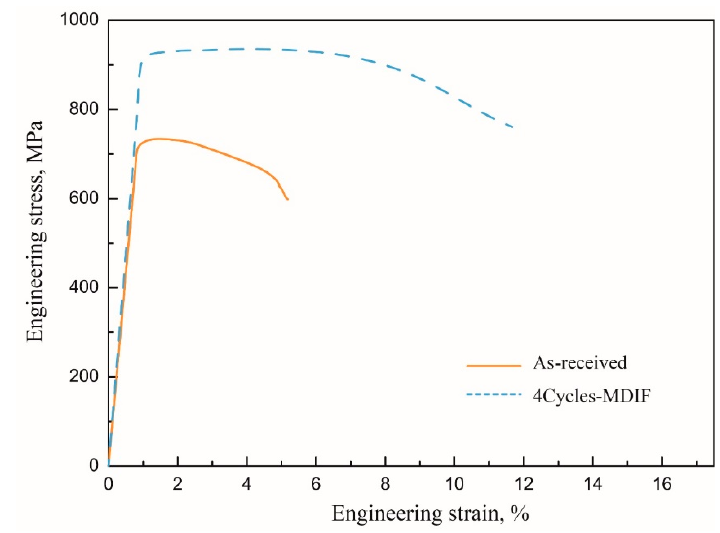
Figure 17. Tensile engineering stress–strain curves of TC4 alloy.